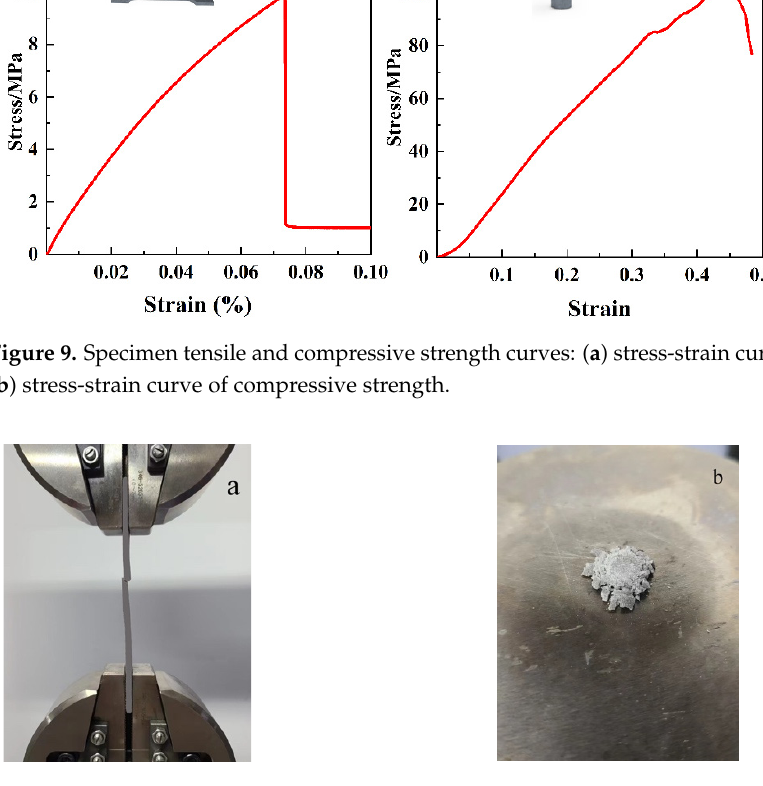
Figure 10. Specimen tensile and compression tests (( a ) tensile; ( b ) compression).